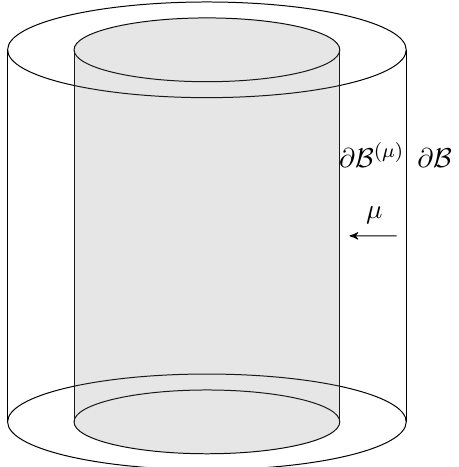
Figure 1 . Illustration of the usual finite-cutoff AdS/CFT duality. The T 2 deformed theory lives on a finite radius brick wall, labelled by ∂ B ( µ )